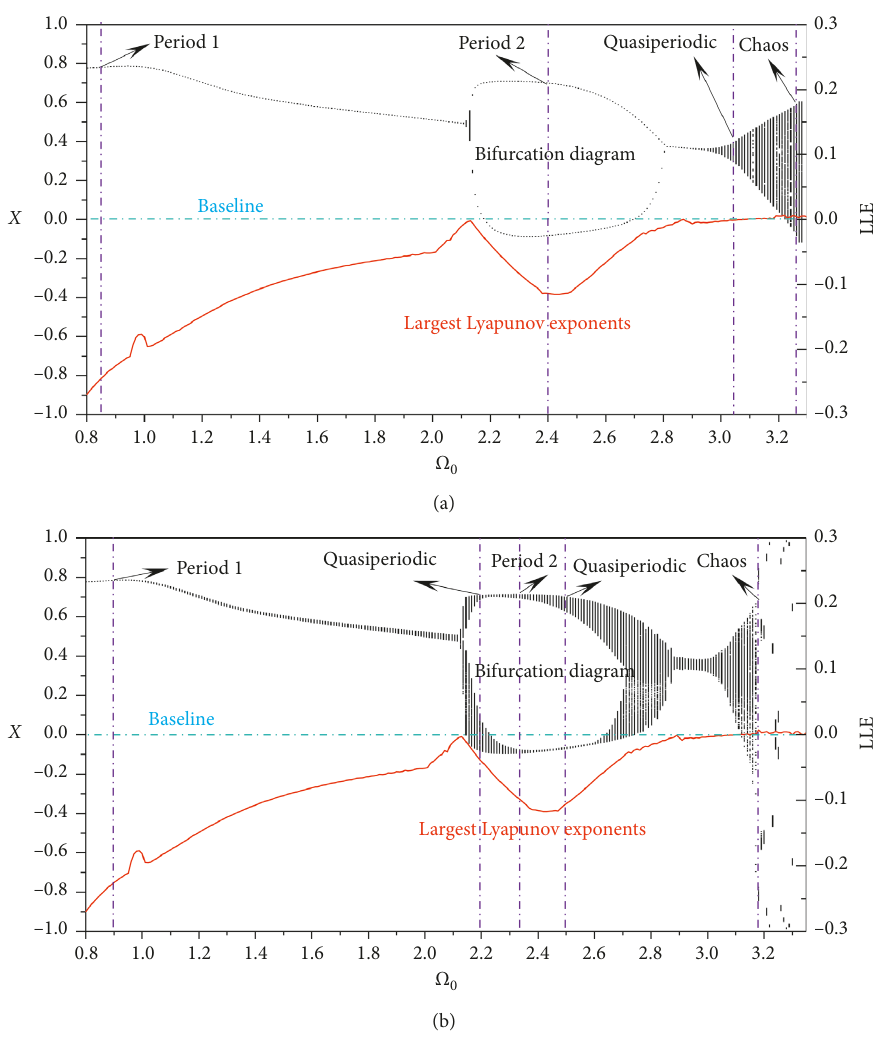
Figure 3: The bifurcation diagram of displacement X and its largest Lyapunov exponents. (a) The steady-state responses of the rotor-bearing system and its largest Lyapunov exponents without heaving. (b) The steady-state responses of the rotor-bearing system and its largest Lyapunov exponents under